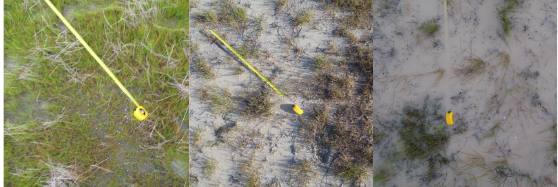
Figure 5: Photographs from sites 1, 2 and 3 (left to right) at Lake Logue.